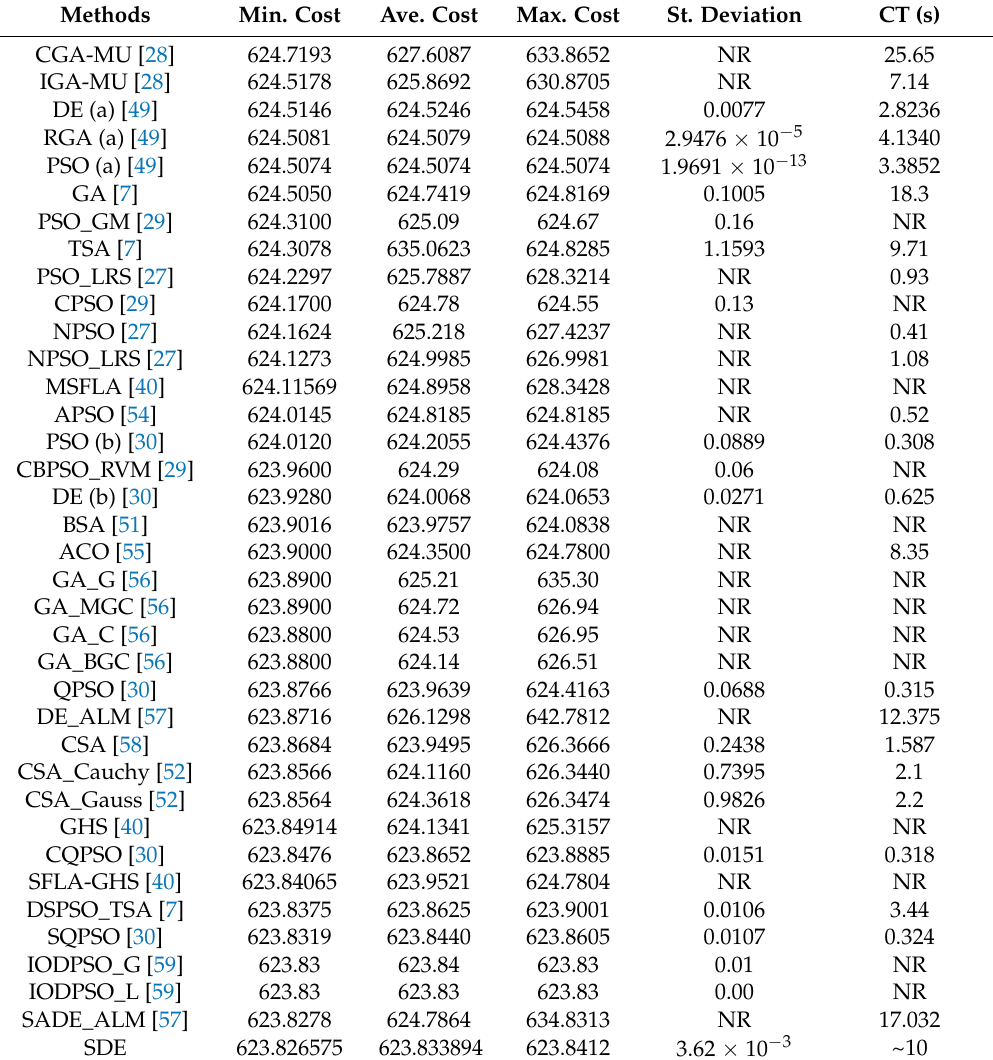
Table 11. Comprehensive comparison of simulation results, standard deviation and computation time for system 2 (with valve point loading effects), P d = 2700